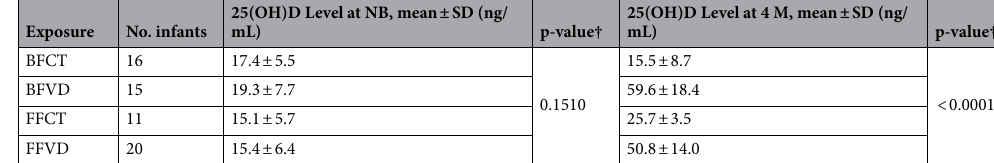
Table 2. Mean serum 25(OH)D levels of the infants with and without vitamin D supplementation. *25(OH)D: 25-hydroxyvitamin D; † Kruskal–Wallis test was used to measure variance in mode of diet.